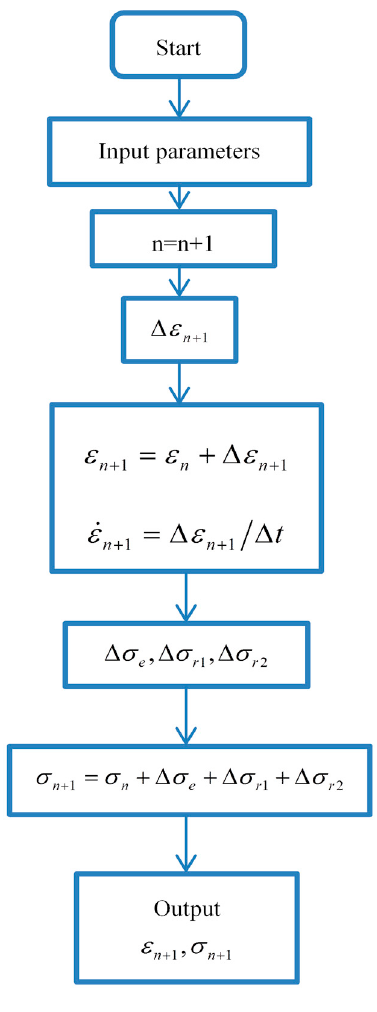
Figure 13. Flowchart of the UMAT subroutine.